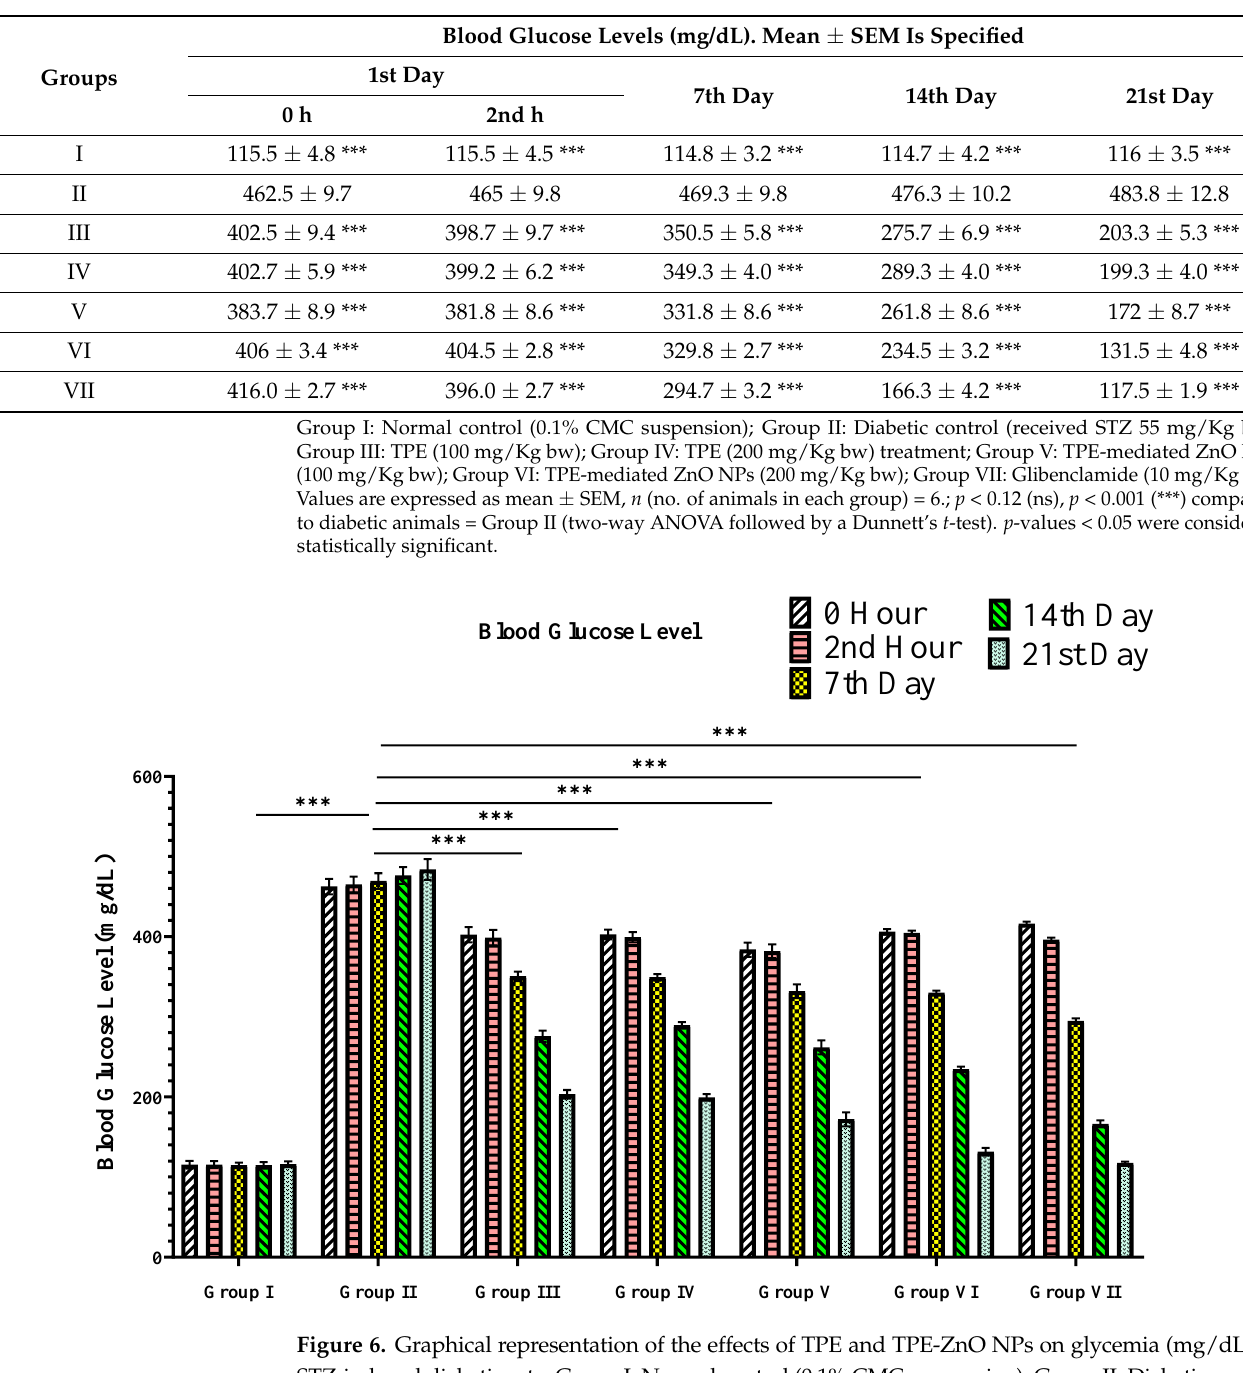
Table 3. Effects of TPE and TPE-ZnO NPs on blood glucose levels (mg/dL) in STZ-induced diabetic rats.